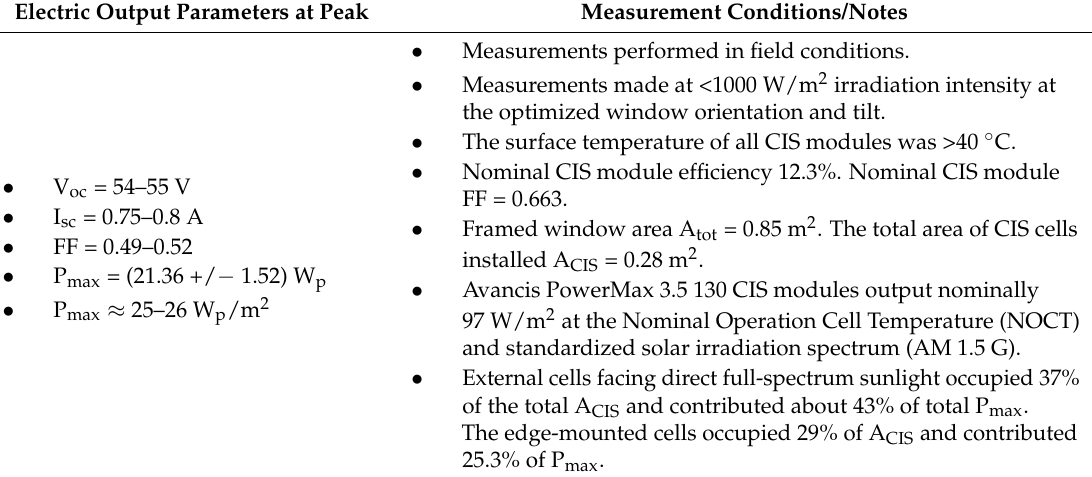
Table 1. Electric output summary and parameters of solar windows used in prototype bus-stop installation. The measurement conditions are described in detail in order to provide an outlook on the potential usefulness of solar window products for use in different applications versus using conventional PV